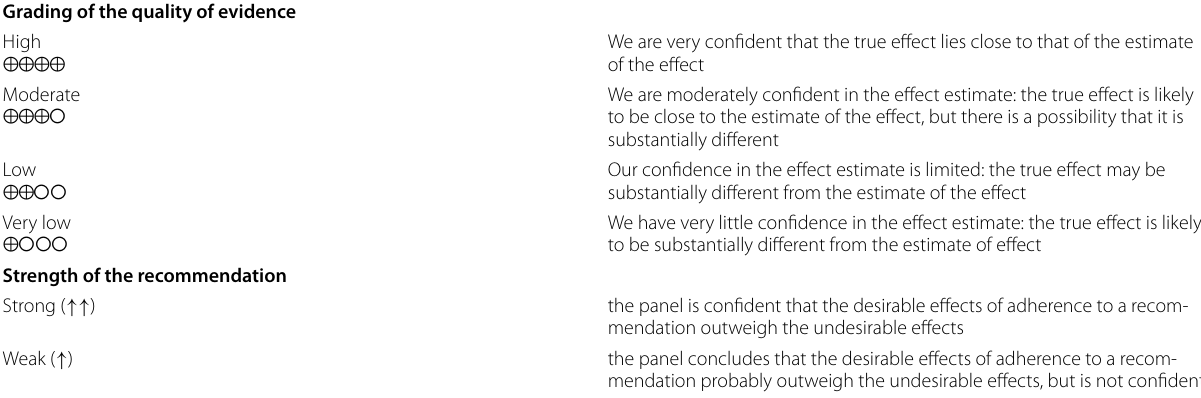
Table 1 Meaning of the different categories of the quality of evidence and of the strength of the recommendation according to the GRADE